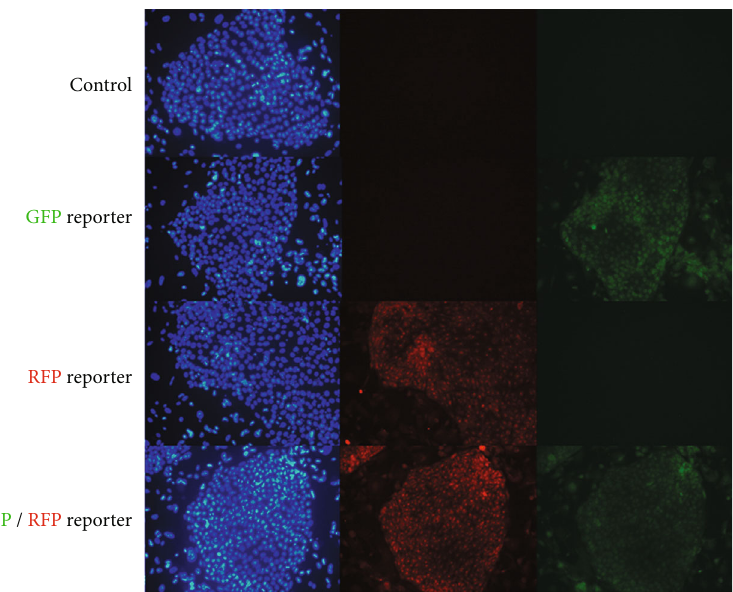
Figure 6: Expression of the fl uorescent signal in porcine embryonic stem cells using the single-color or dual-reporter system. The porcine OCT4 reporter system consists of two reporters: DE-GFP and PE-RFP. Because each reporter is separate from the other, the reporter system can be used simultaneously. Control: porcine embryonic stem cells without any OCT4 reporter system. GFP reporter: porcine embryonic stem cells with the DE-GFP reporter vector only. RFP reporter: porcine embryonic stem cells with the PE-RFP reporter vector only. GFP/RFP reporter: porcine embryonic stem cells with the dual- OCT4 reporter